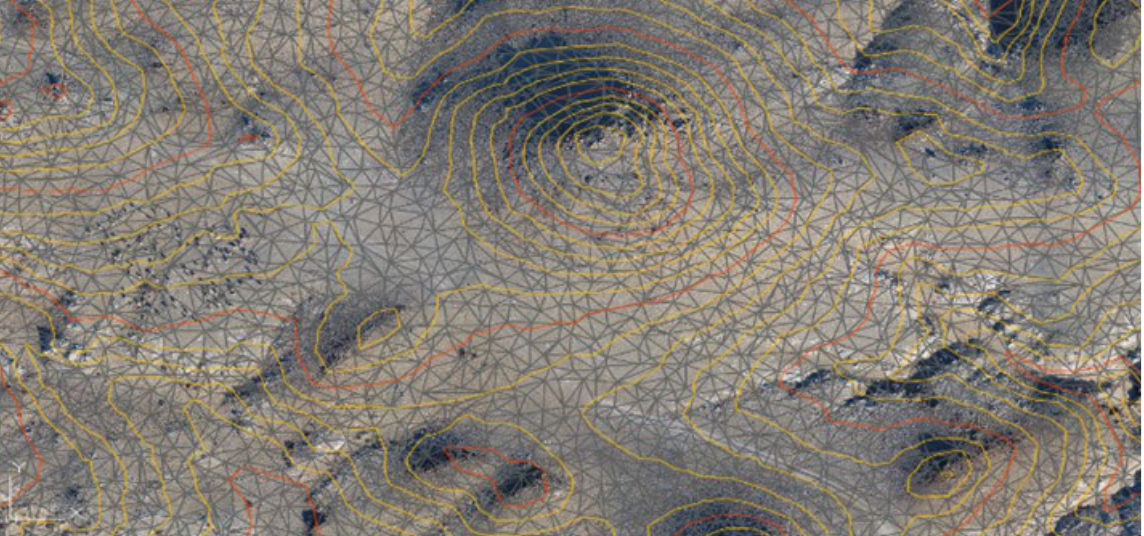
Fig. 2. Orthophoto of the photogrammetric project with contour